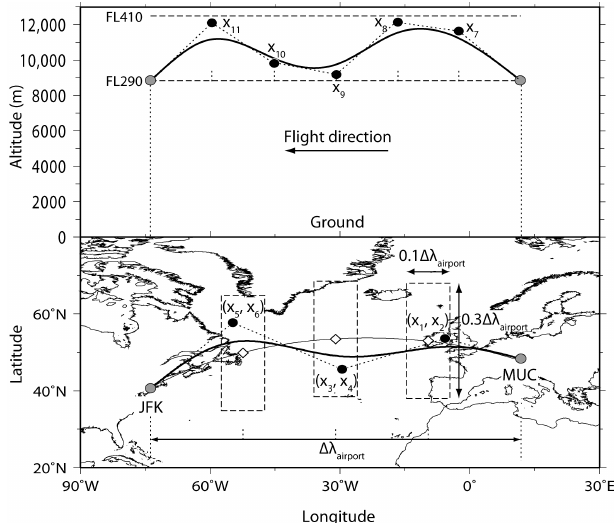
Figure A1. Geometry definition of the flight trajectory in the vertical cross section (top) and projection A1 on the Earth (bottom) [27]. The bold solid line indicates a flight trajectory from Munich (MUC) to New York (JFK). Control points (closed circles) are determined by 11 design variables. Bottom: the dashed boxes show rectangular domains for the lower/upper variable bounds of the six design variables ( x 1 to x 6 ). Central points (diamonds) of the domains are calculated on the great circle (thin solid line). Top: the dashed lines show the lower/upper variable bounds of the five design variables ( x 7 to x 11